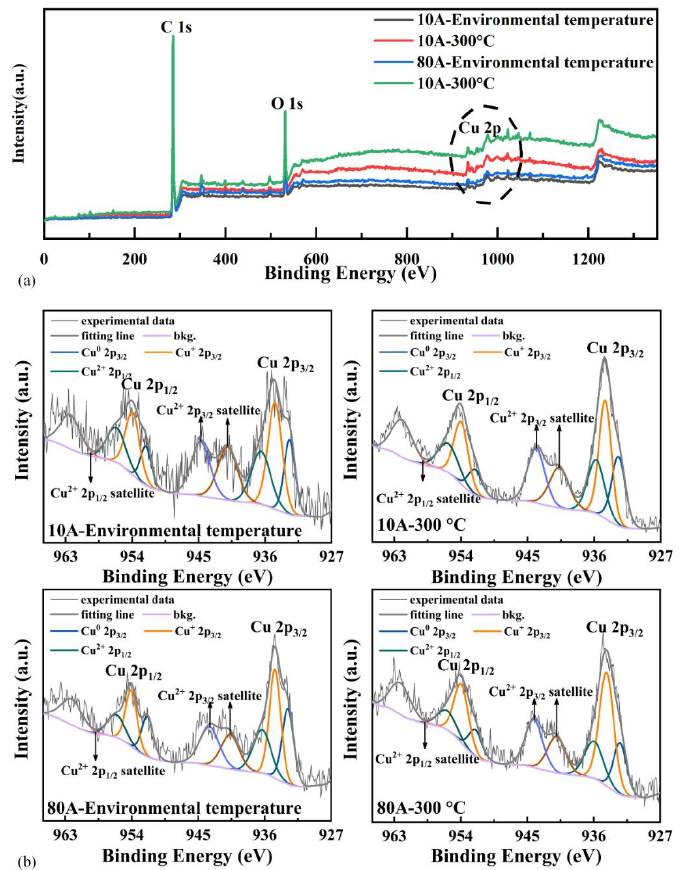
Figure 7. XPS spectrum of the carbon surface with different temperature and current: ( a ) XPS survey-scan spectrum and ( b ) the corresponding Cu 2p peak. The copper contact line material is transferred to the carbon surface in two main ways. One is through material transfer caused by friction and wear [22]. Another is the [23]. As can be seen from Figure 5, the total discharge energy remained stable with the variation in the interface temperature at 10 A, indicating that the copper transfer was caused by the discharge and was constant. The high interface temperature aggravated the adhesion effect between the carbon – copper interface, and more copper adhered to the carbon surface in the friction process. However, the total discharge energy decreases with the increase in interface temperature at 80 A, so the copper transfer caused by discharge decreases. Meanwhile, joule heat increases rapidly at 80 A, and the temperature of the contact spots may exceed the softening temperature of copper under the synergistic effect of joule heat and interface temperature. Thus, the copper spots are more likely to undergo plastic deformation under the cutting action of the carbon spots, reducing the amount of copper fractured and transferred to the carbon surface. This is the main reason why the copper content on the carbon surface at 80 A and 300 °C is lower than the case at 10 A and 300 °C. In addition, the increase in discharge energy is the main reason for higher copper